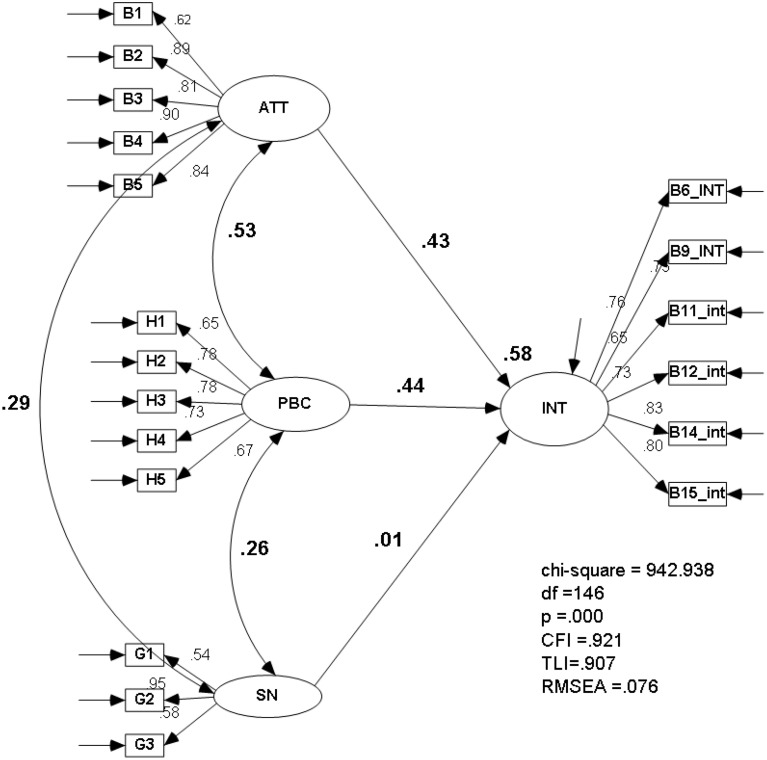
Structural Model (standardized results). Circles represent latent factors; boxes represent indicators. Casual effects are given by arrows connecting circles. Bold numbers over paths are structural weights. Disturbance effects and variance explained for the indicators are omitted for clarity.